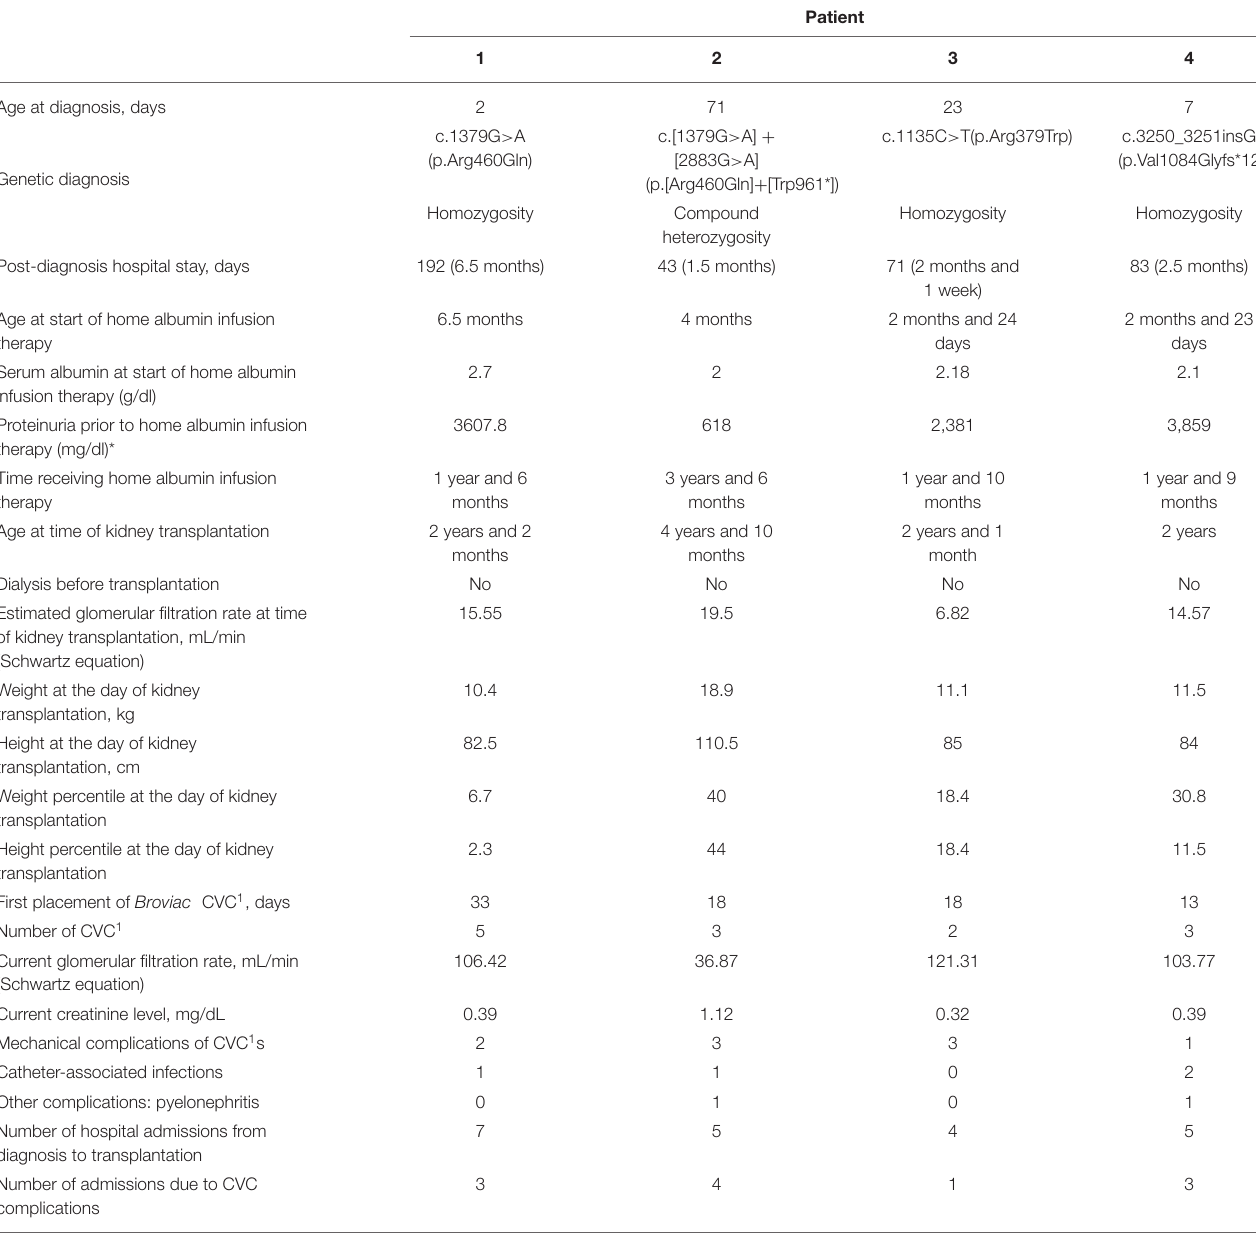
TABLE 2 | Clinical and demographic characteristics of